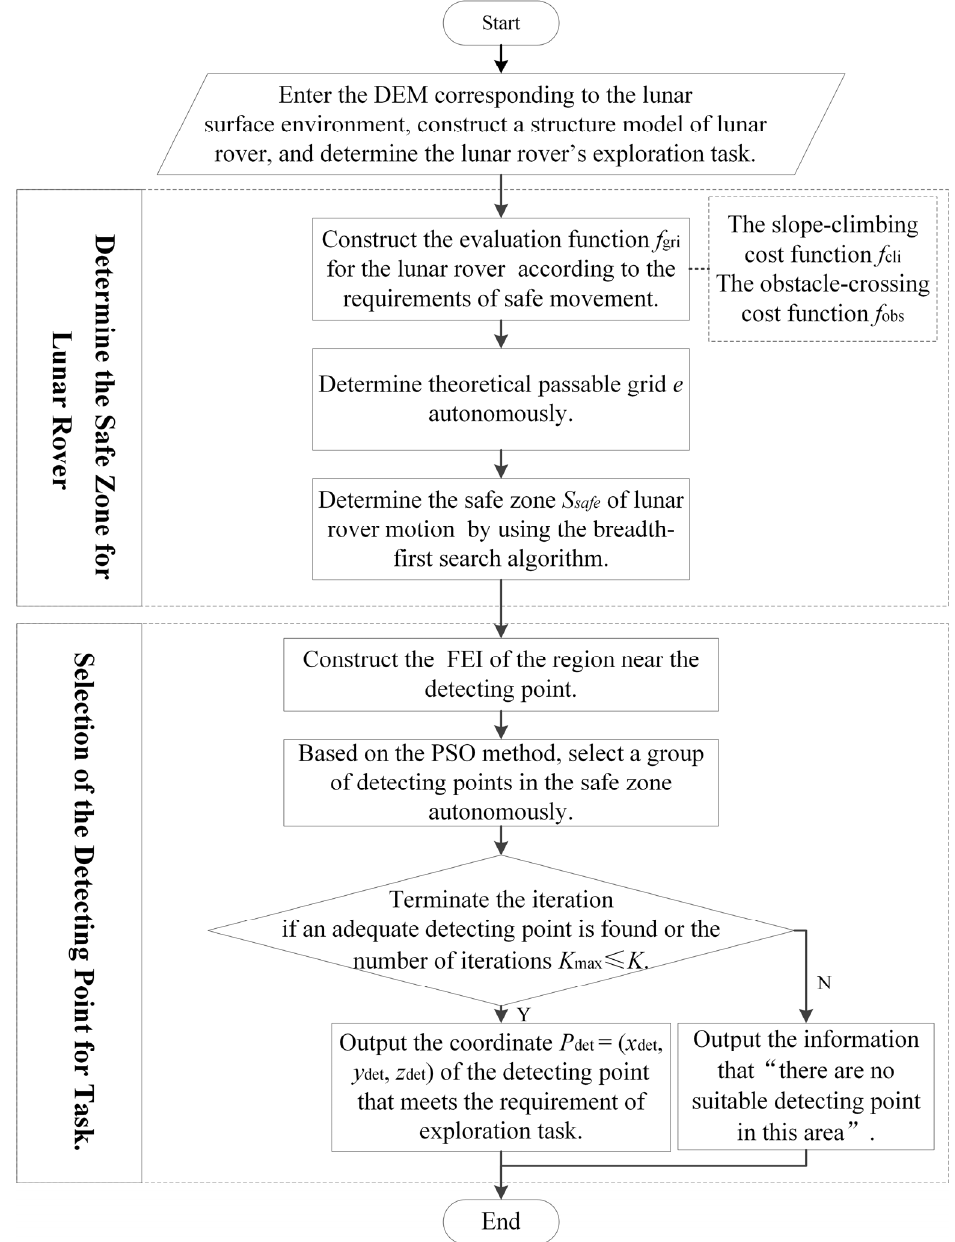
Figure 6. The flow of detecting point selection of lunar rover.